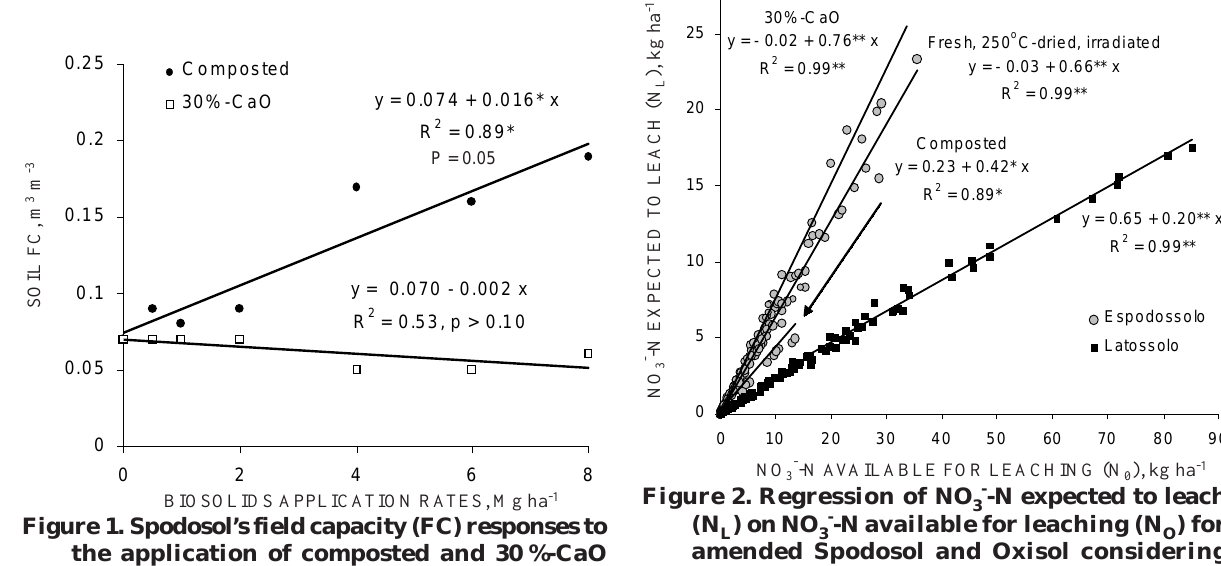
Figure 1. Spodosol’s field capacity (FC) responses to the application of composted and 30 %-CaO biosolids.